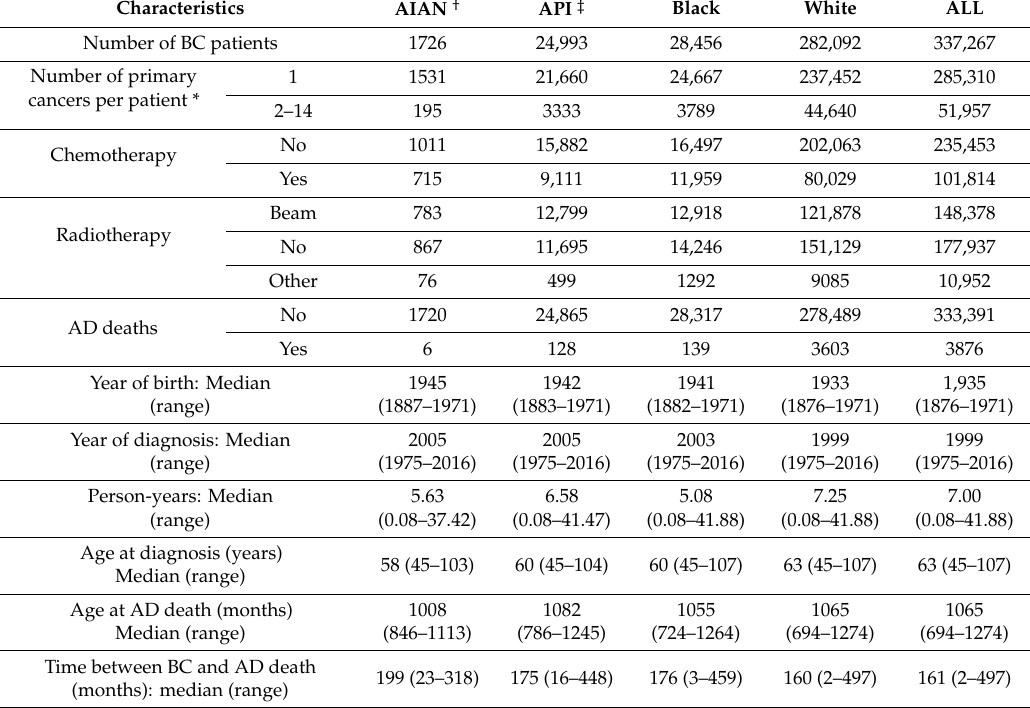
Table 5. Cohort characteristics for 337,267 breast cancer cases from the SEER 9 registry included into analysis of the e ff ects of chemotherapy, radiotherapy and demographic / clinical factors on the risk of AD